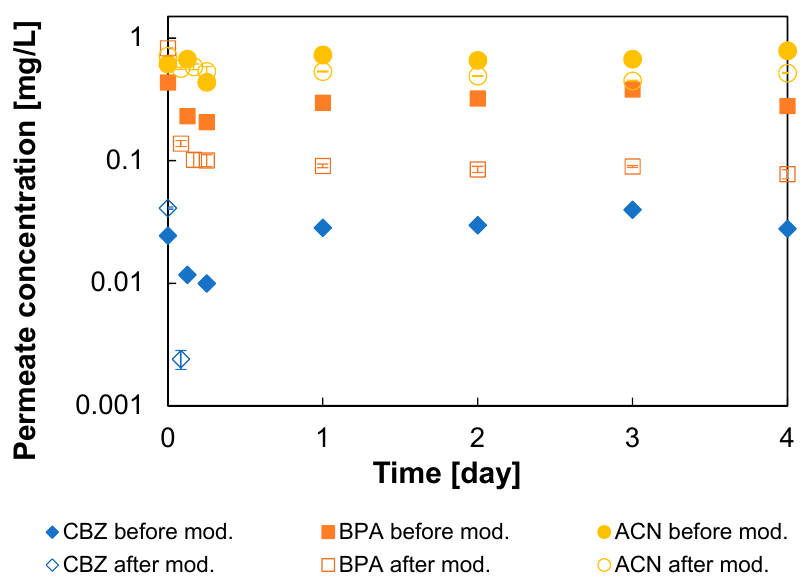
Figure 6. Permeate concentrations of carbamazepine (CBZ), bisphenol-A (BPA), and acetaminophen (ACN) measured for ESPA1-2521 elements before and after modification as a function of time. Modification was performed for 0.5 h using 2 mM GMA with the addition of 0.045 mM Triton. The filled and open symbols represent concentrations before and after modification, respectively. CBZ concentration in permeate after modification became undetectably low after one day. Table 2. Passage of carbamazepine (CBZ), bisphenol-A (BPA), and acetaminophen (ACN) and permeability before and after modification of the ESPA1 element for 0.5 h using 2 mM GMA